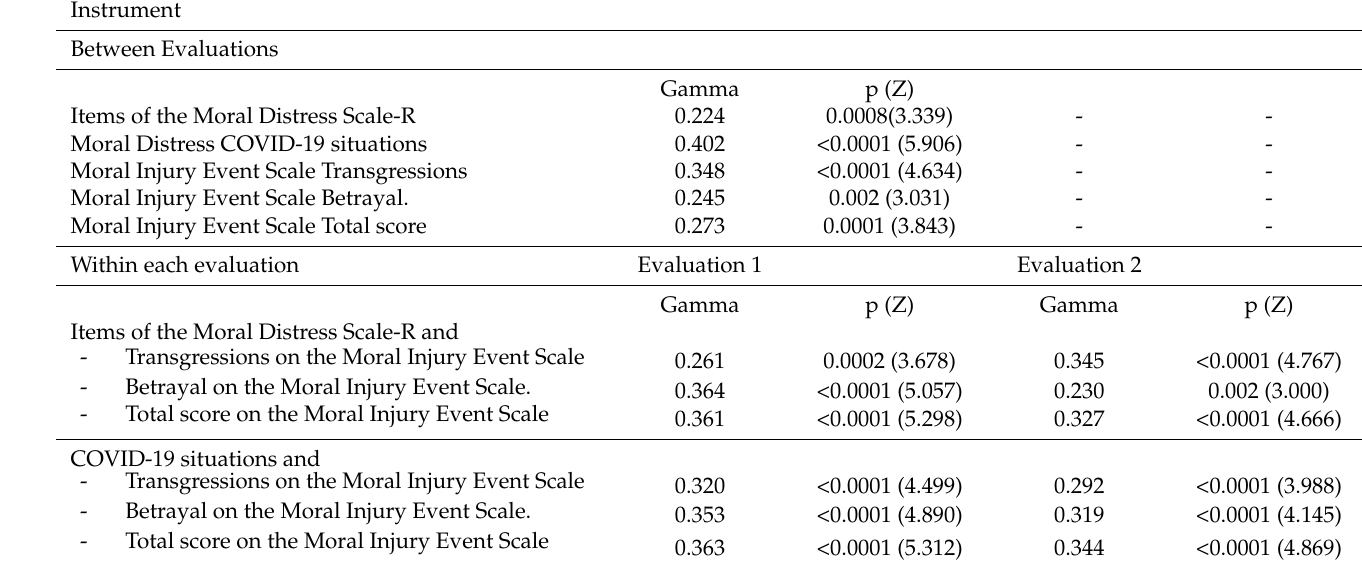
Table 4. Goodman–Kruskal gamma (G) correlation coefficients between moral distress and moral injury scores of 108 physicians, between evaluations 1 and 2 and within each evaluation.